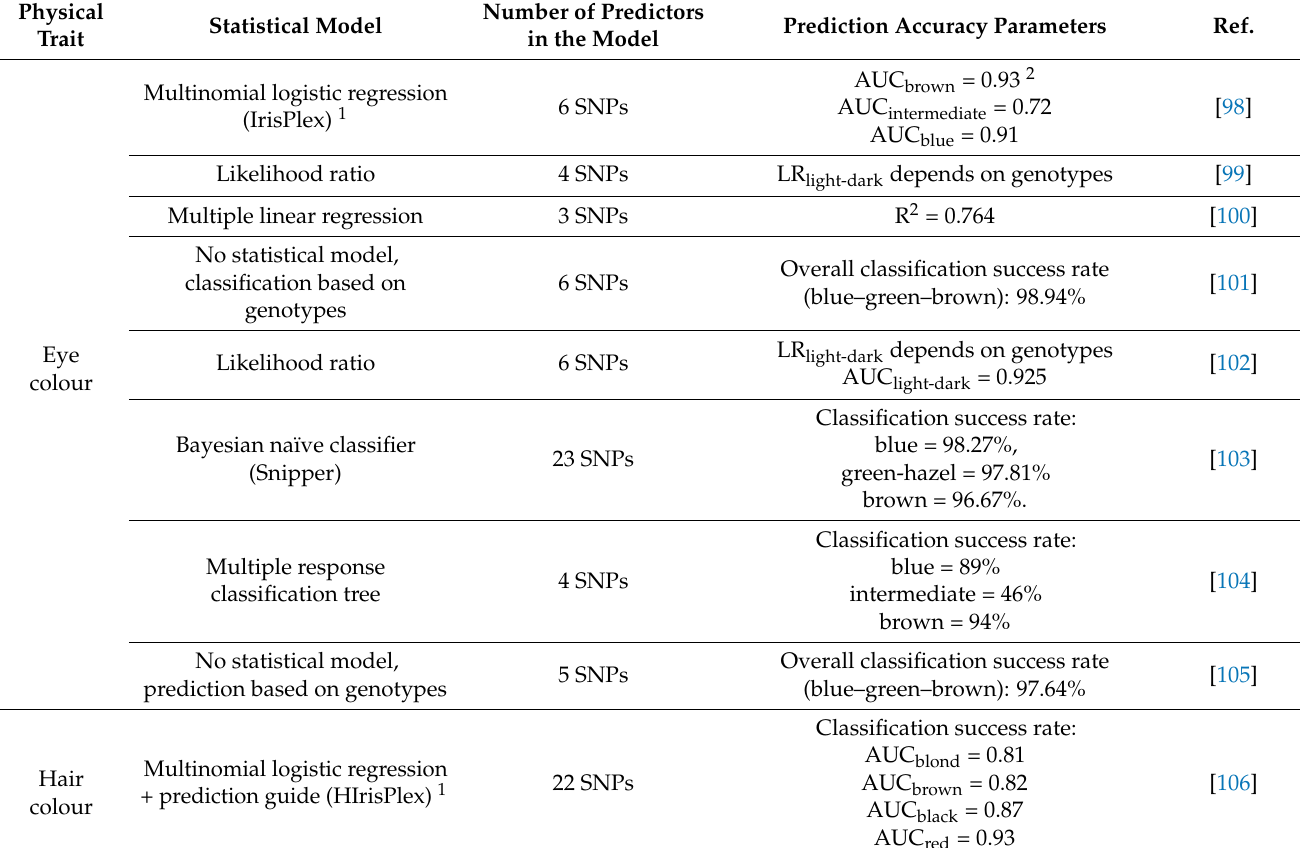
Table 1. Examples of various approaches proposed for genetic prediction of physical